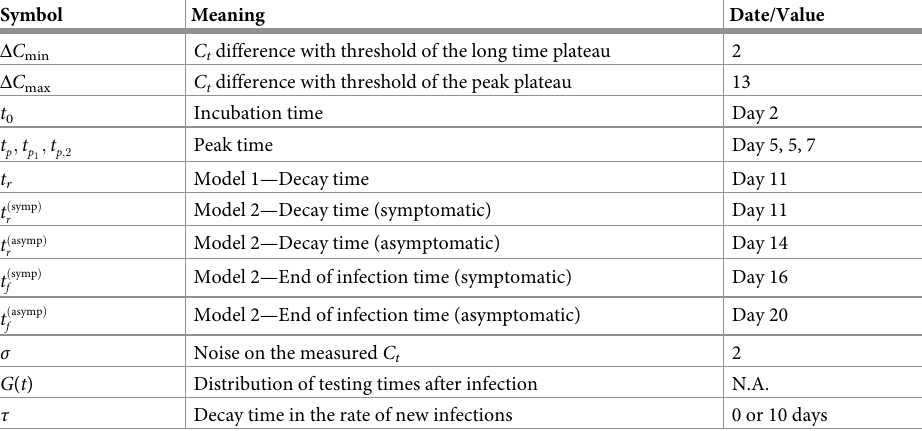
Model 2—End of infection time